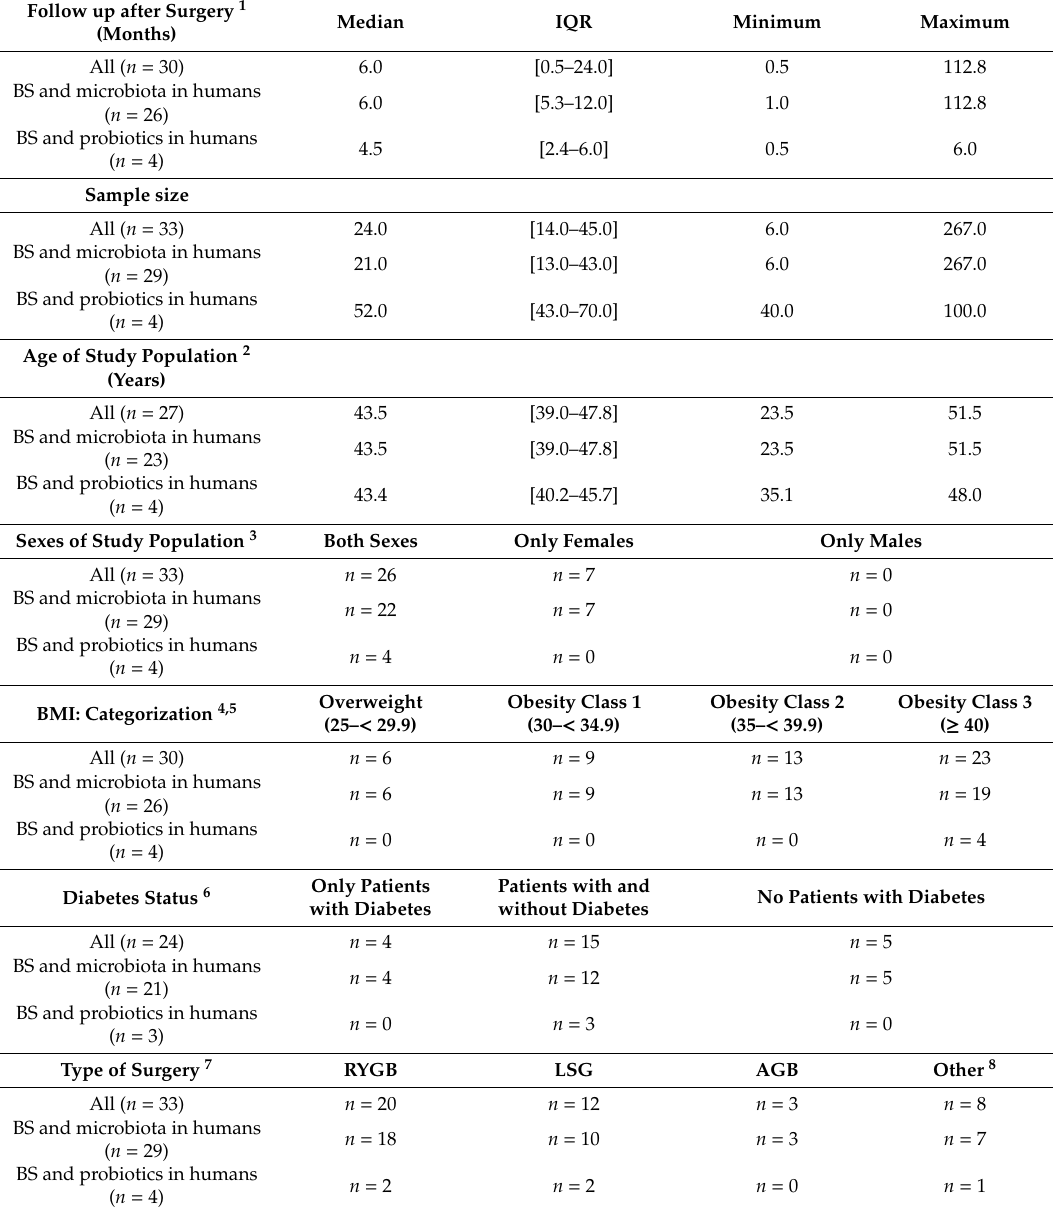
Table 1. Characteristics across human studies—Groups 1 and